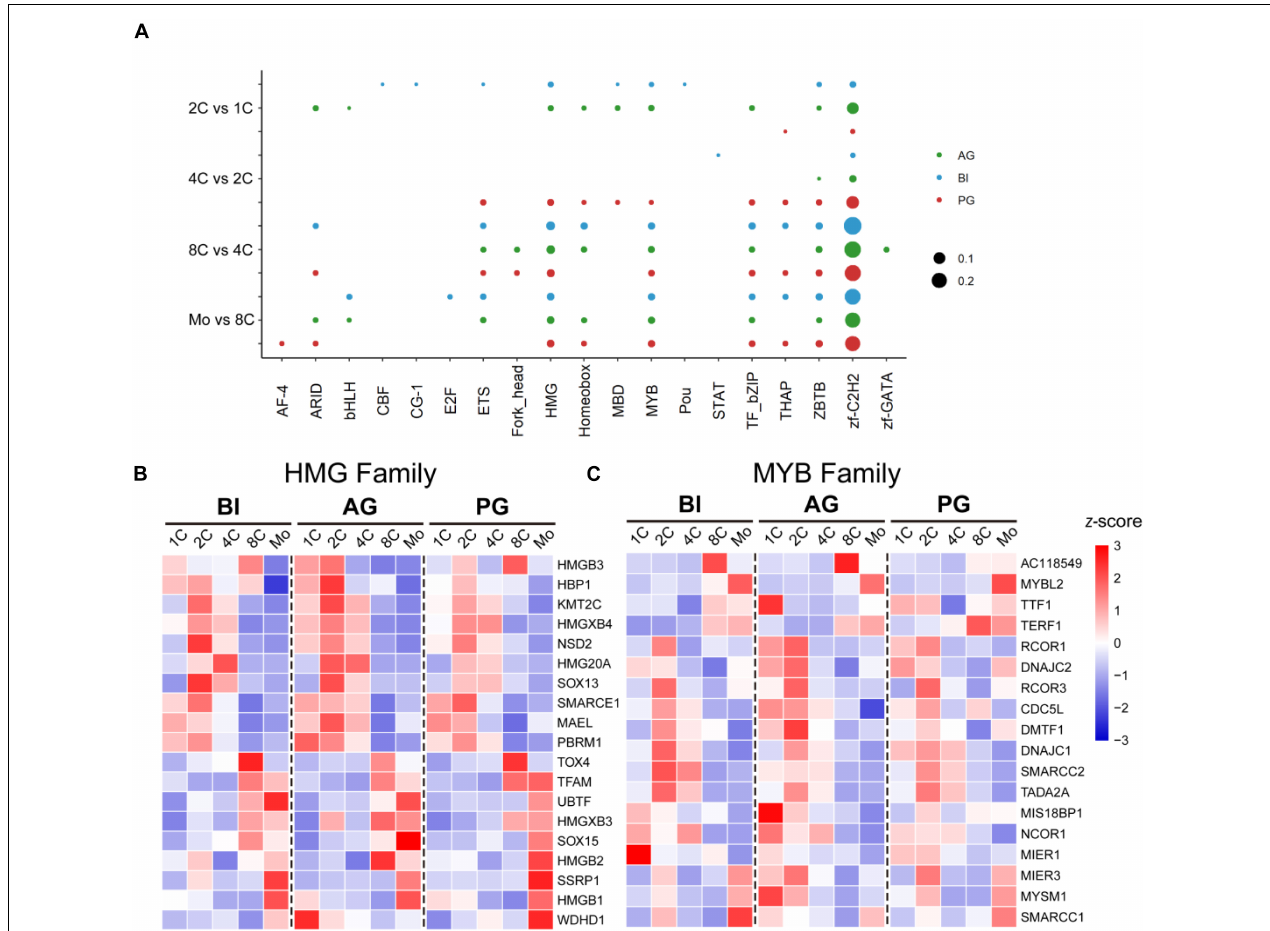
FIGURE 3 | Dominant TF families in biparental and uniparental early embryogenesis based on DE-TFs in successive developmental stages. Zf-C2H2, HMG, and MYB families are the top 3 TF families. (A) The rate of the top 10 TF families in each transitional stage of different original embryos. (B) The dynamic expression of the HMG family. (C) The dynamic expression of the MYB